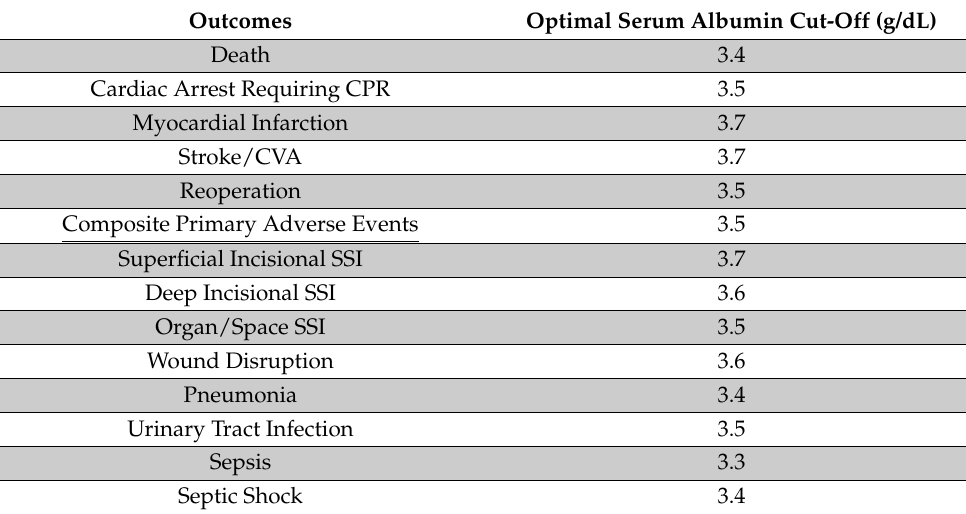
Table 1. Optimal serum albumin cutoff (g/dL) to predict 30-day postoperative adverse